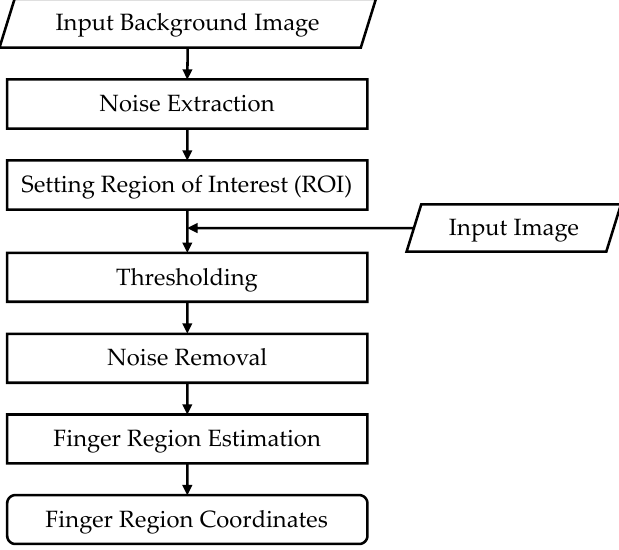
Figure 2. Finger area extraction algorithm.